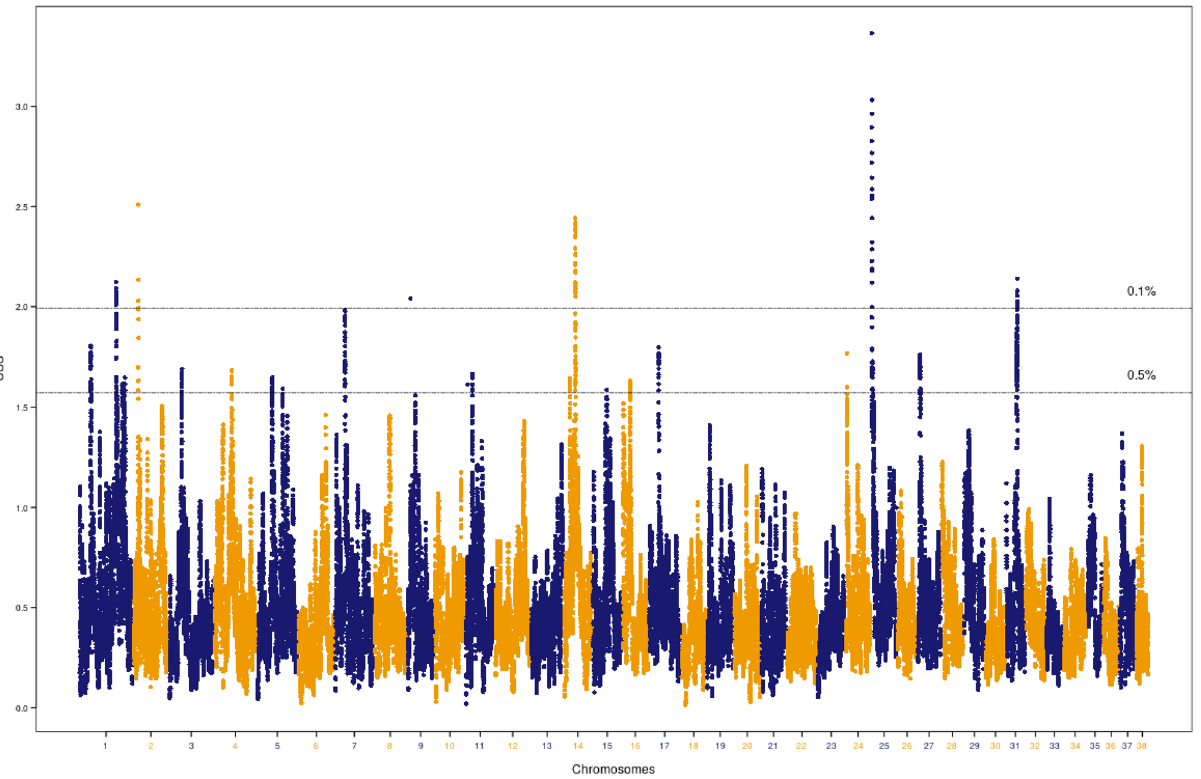
Figure 3. Composite selection signals associated with running speed. CSS statistics were determined with Xi dogs as the target group. The canine chromosomal positions of SNP markers are plotted on the x-axis. The observed values for selection scan statistics based on the combination of F st , ∆DAF and XP-EHH are highlighted in blue and orange. Each point represents the smooth CSS value in a 1 Mb overlapping sliding window across the autosomes. The two-dashed horizontal lines indicate threshold values for the top 0.1% (top) or 0.5% (bottom) of CSS